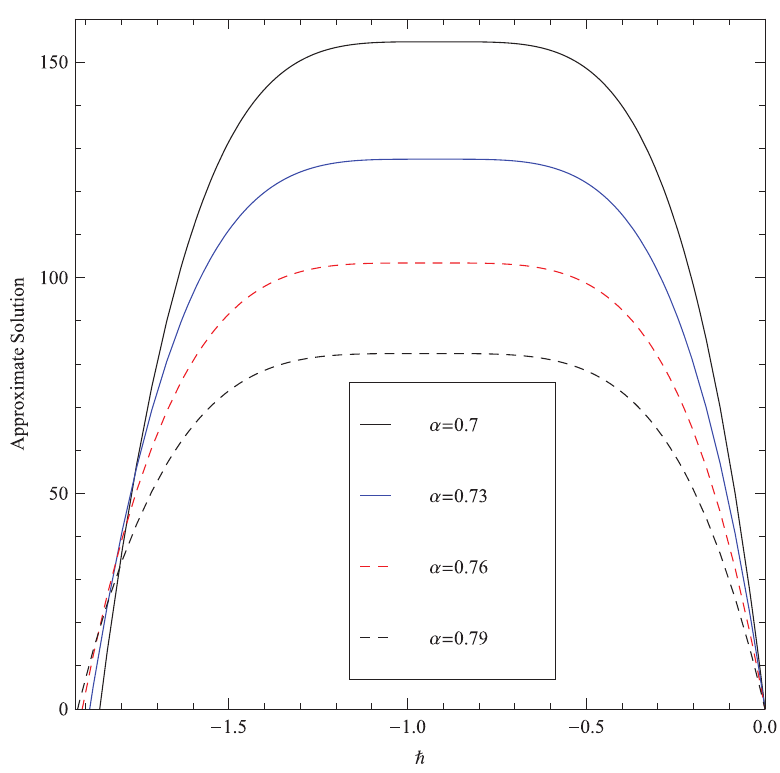
Figure 4. Plot of ℎ curves for different values of α : α = 0.7, 0.8, 0.9 and